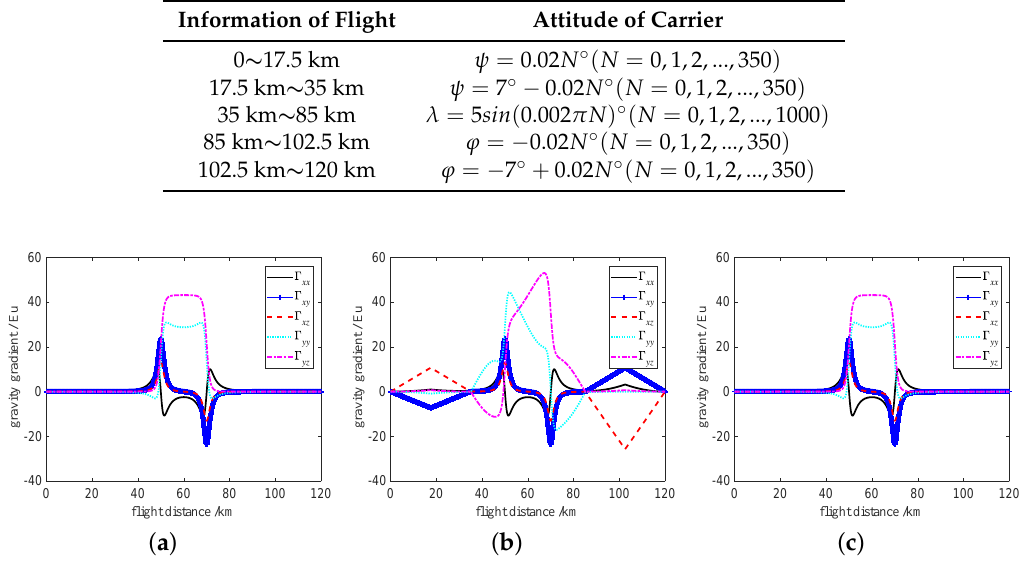
Figure 10. Gravity gradient real ideal value and results of the self-gradient compensation. ( a ) Real ideal gravity gradient value of the anomaly-body. ( b ) Before self-gradient compensation. ( c ) After Self-gradient compensation.